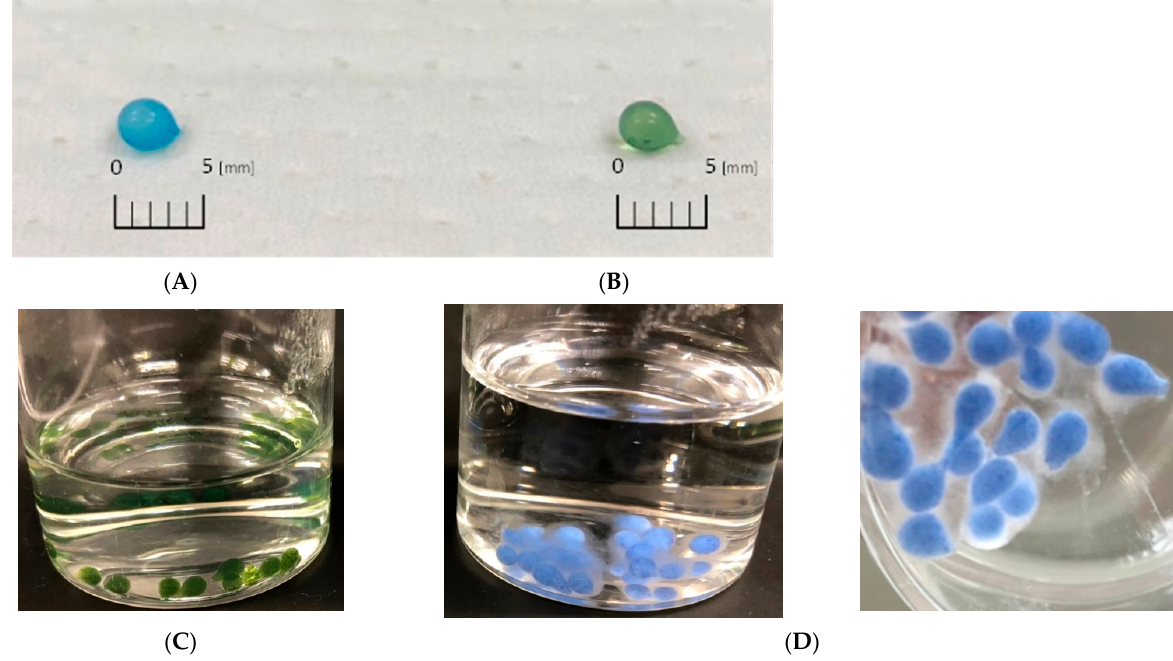
Figure 2. Images of chitosan or amidoxime-chitosan/cellulose gel beads after copper adsorption, immediately after copper adsorption (( A ) chitosan, ( B ) amidoxime chitosan), and after three months (( C ) amidoxime chitosan, ( D ) chitosan).